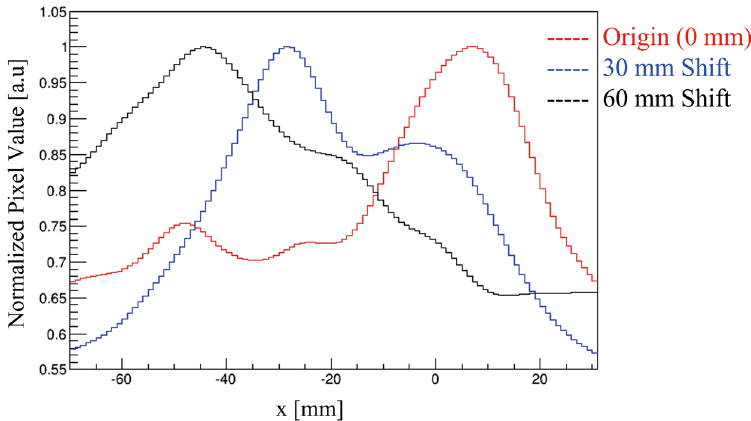
Figure 4. Normalized x-projection profile of the reconstructed Compton images of 718 keV illustrated in Figure 3, acquired using the graphite phantoms positioned at: 0 mm, red line; 30 mm, blue line; and 60 mm, black line. The x-projection profile was calculated within the projection range indicated by the dotted line in Fig. 3b.